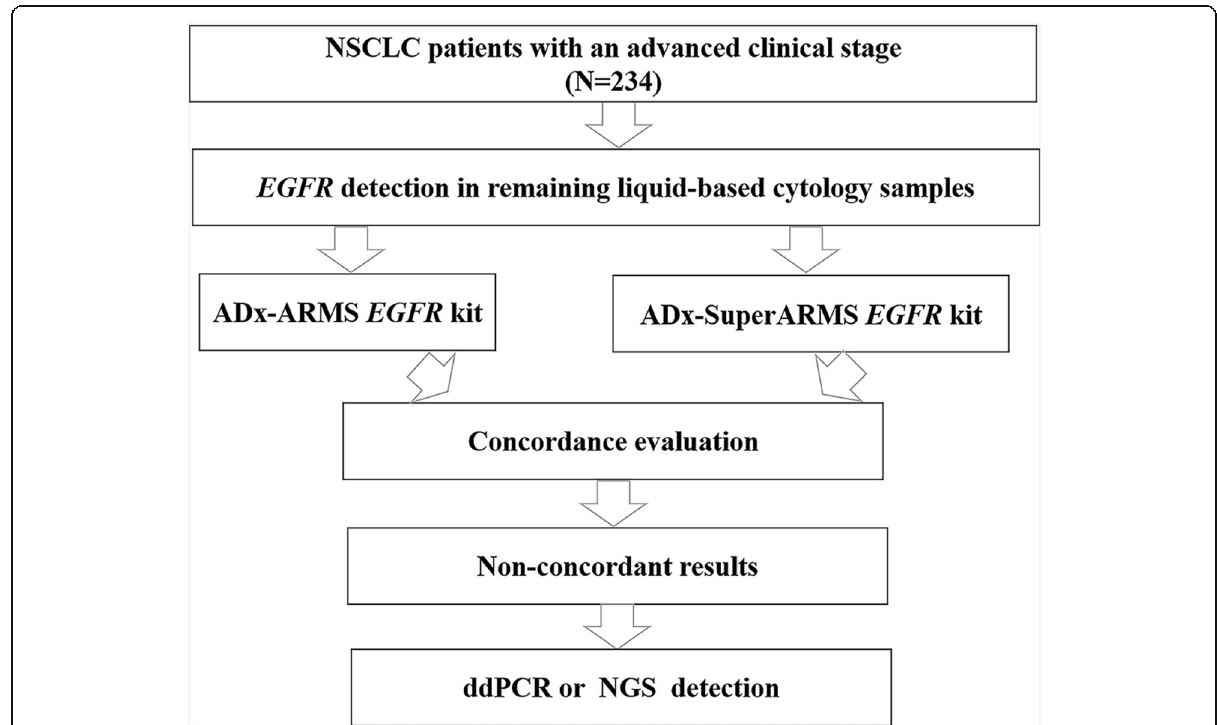
Fig. 1 A flowchart describing the study designAbbreviations: NSCLC = non-small cell lung cancer; EGFR = epidermal growth factor receptor; NGS = next-generation